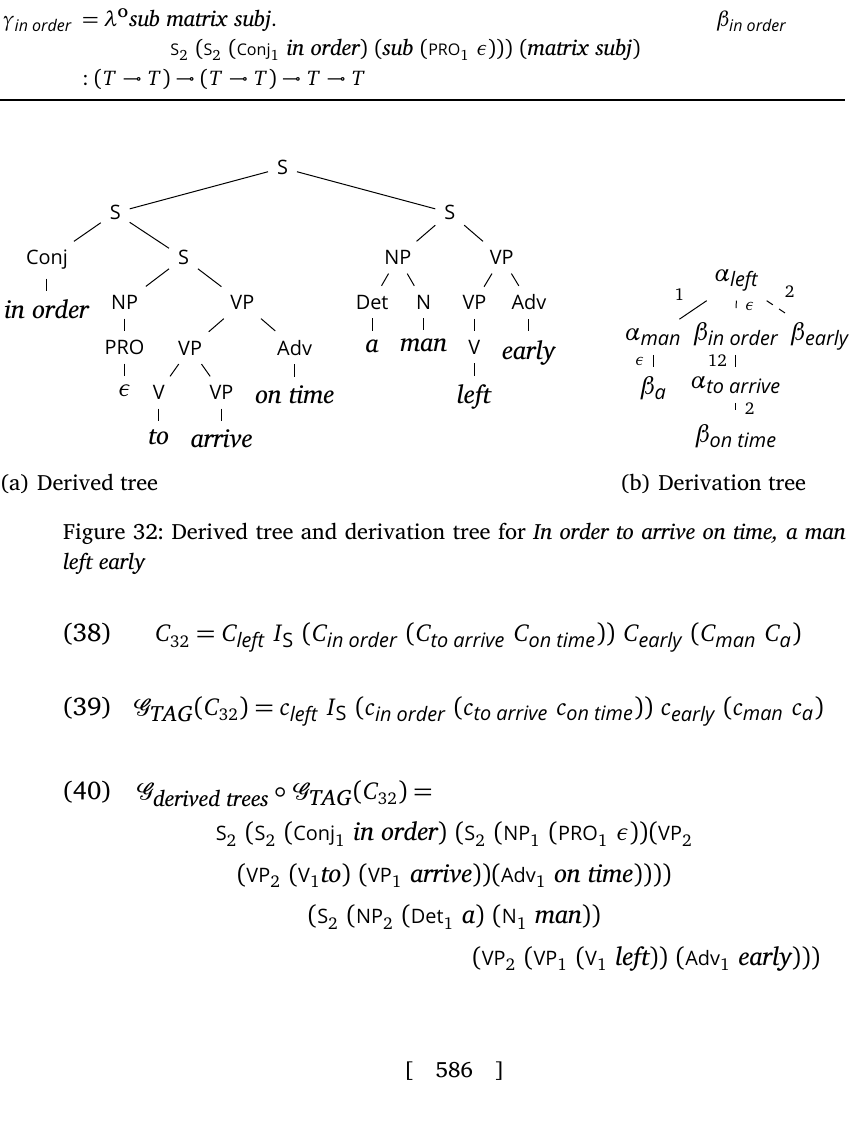
Table 22: TAG elementary tree encoding as (cid:3)((cid:6) trees ) terms Terms of (cid:3)((cid:6) trees ) TAG